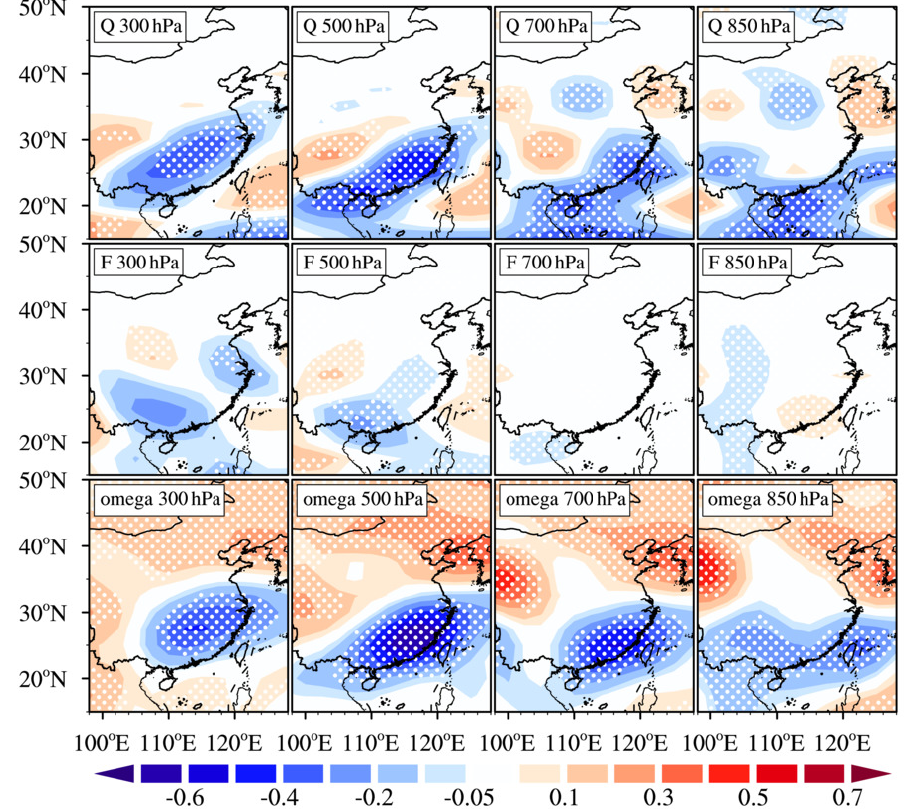
Figure 12. Composite QG decomposition for the 13 SR–NH events. Each column shows a different level. From top to bottom, the rows (cid:18) (cid:19) R ∇ 2 Q ∇ 2 Ad v T ), where Q is calculated using the Eq. (1), ∂ p Ad v ζ + R show the diabatic heating term , the dry forcing term ( F = 1 f pf 2 pf 2 and ω (reanalysis data), respectively. The unit of ω is Pas − 1 . The unit of the F and Q terms is Pa − 1 s − 1 . For ease of viewing, and to reduce the differences in scale, the F , Q terms, and ω were multiplied by 4 × 10 7 , 0 . 8 × 10 7 , and 4, respectively. Dotted white regions indicate areas at the 95% confidence level based on the two-tailed Student t